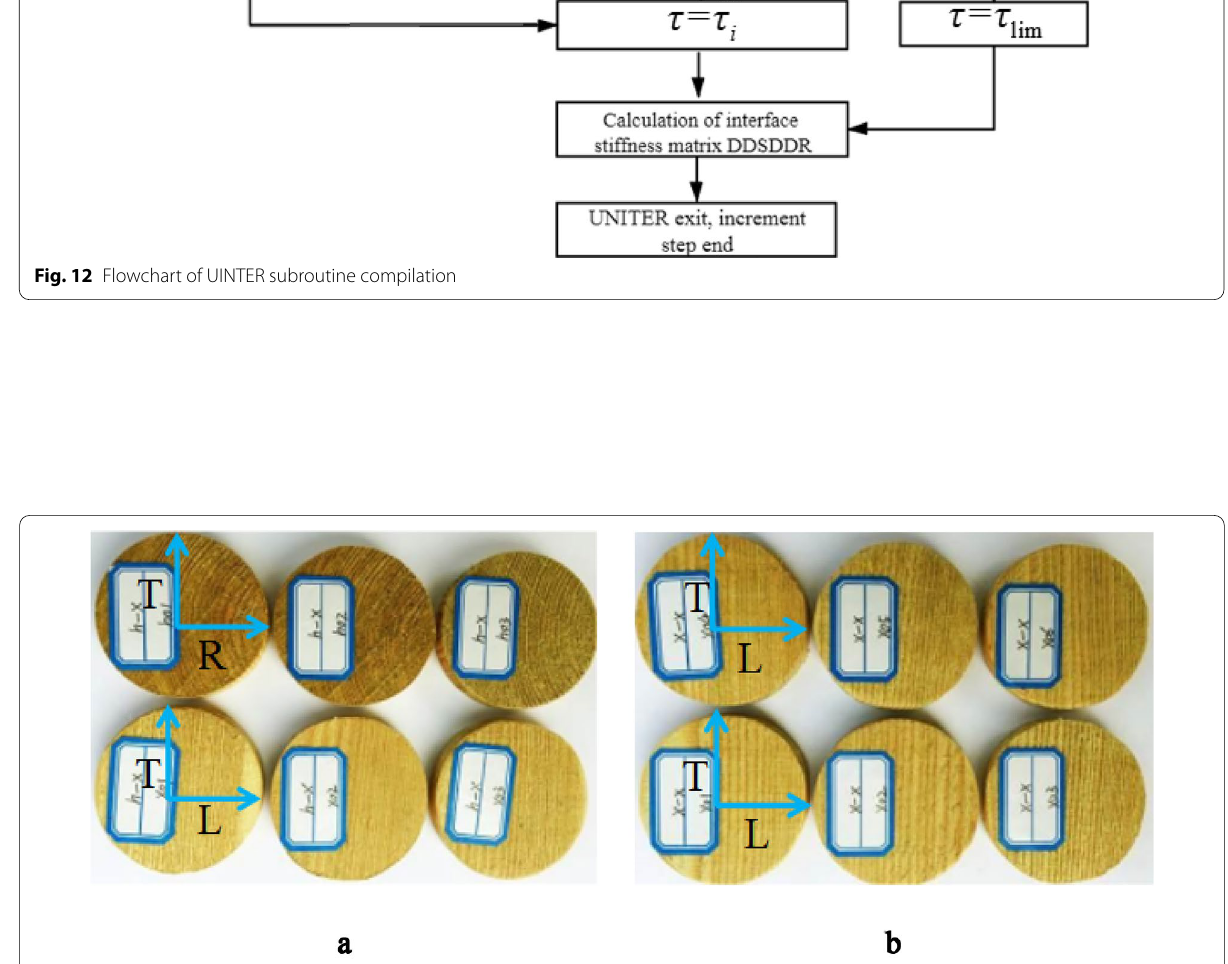
Fig. 13 Physical diagram of contact surface of samples: a transverse–tangential contact surface; b tangential–tangential contact